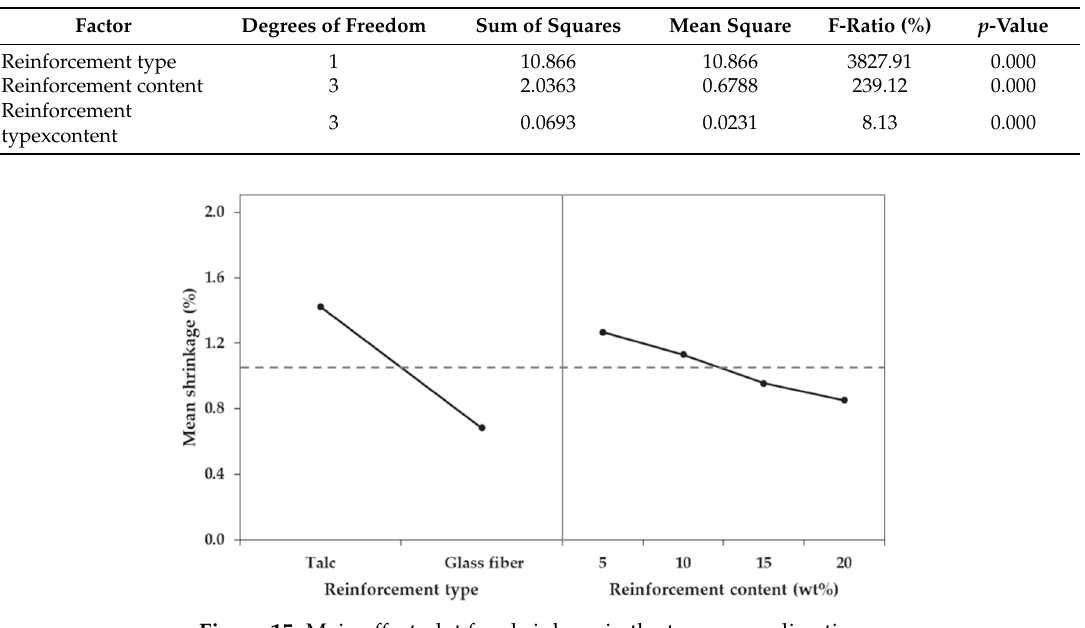
Figure 15. Main effect plot for shrinkage in the transverse direction. Table 8. Two-way ANOVA of differential shrinkage.